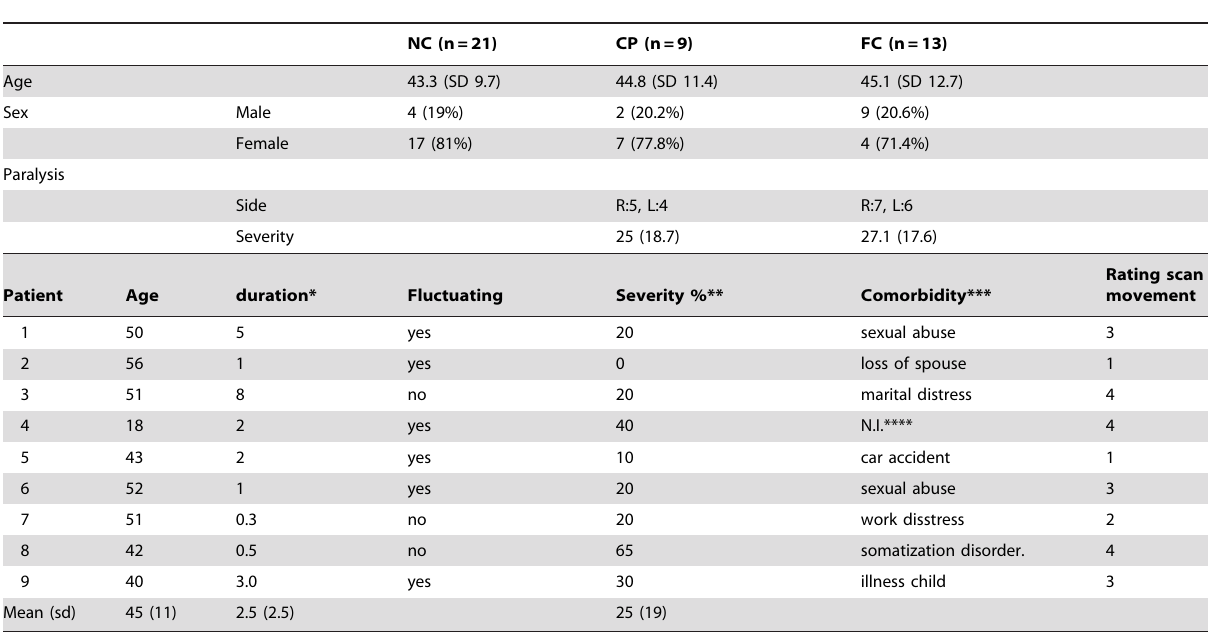
Table 2. Demographic and illness